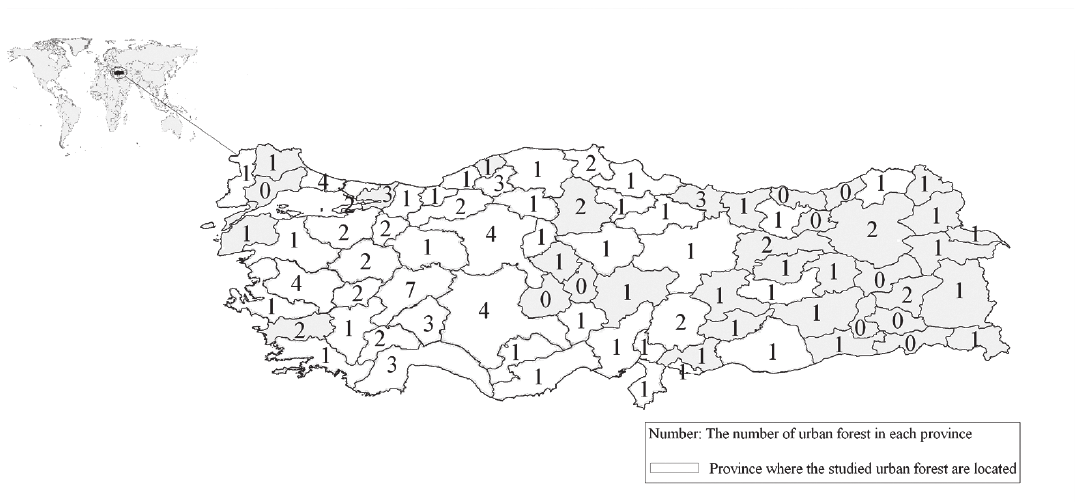
Distribution of urban forests in